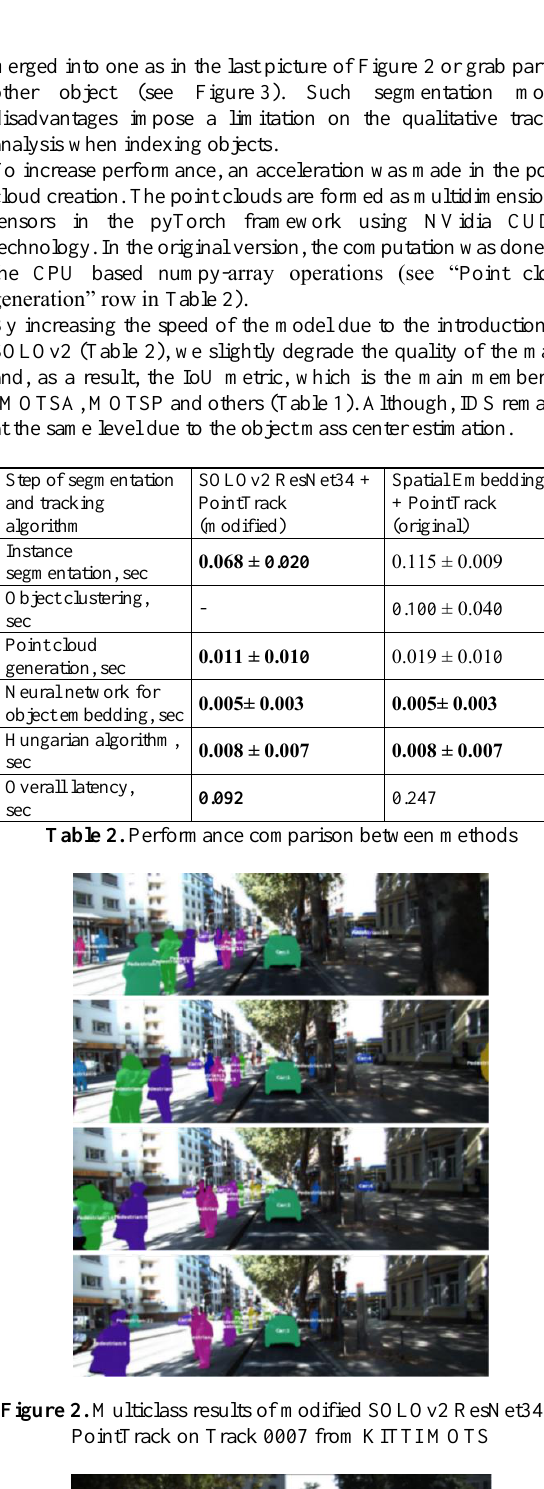
Figure 2. Multiclass results of modified SOLOv2 ResNet34 + PointTrack on Track 0007 from KITTI MOTS